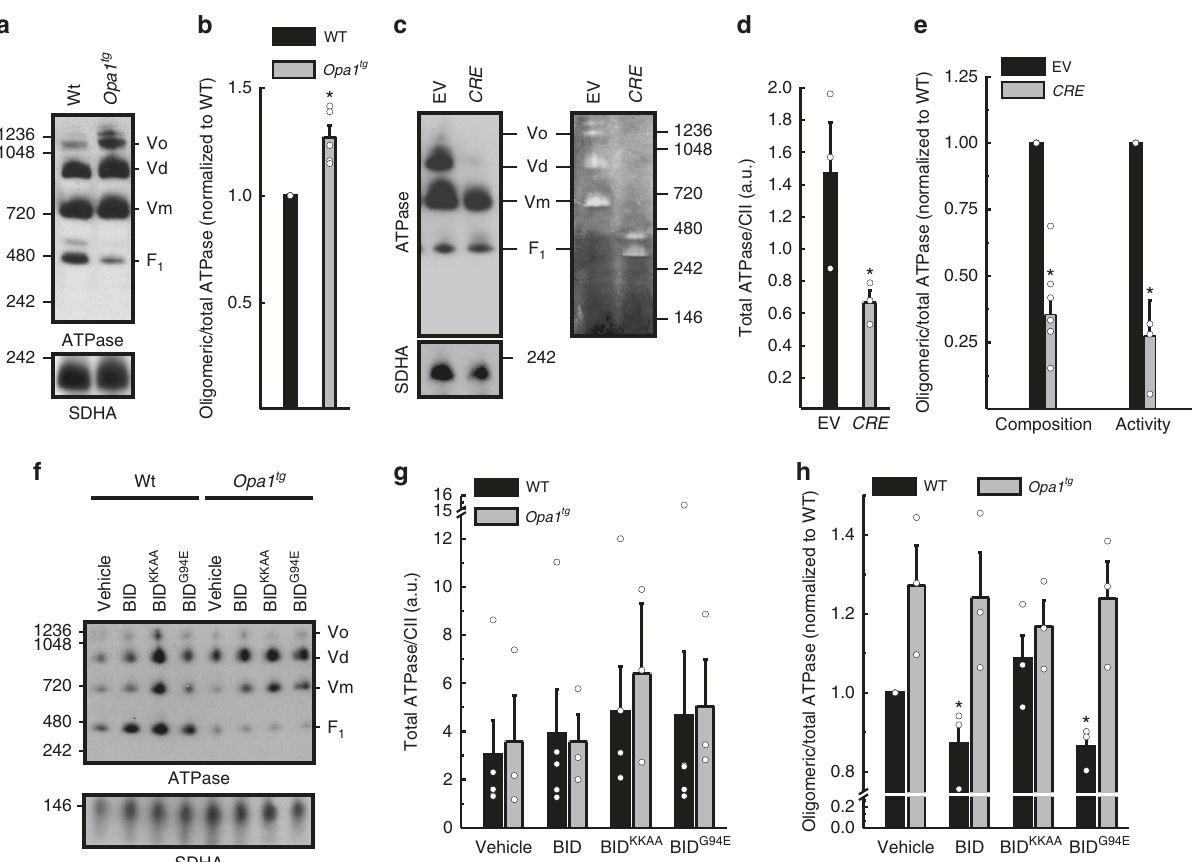
Fig. 3 OPA1 promotes stabilization of ATP synthase oligomers. a Equal amounts (40 µ g) of digitonin-solubilized mitochondrial extracts from MAFs of the indicated genotype were separated by BNGE and immunoblotted with anti-ATP synthase subunit α (ATPase) and Succinate Dehydrogenase (SDHA) antibodies. ATPase oligomers (Vo), dimers (Vd), monomers (Vm) and F 1 are indicated. b Densitometric analysis of experiments performed as in a . Data represent mean ± SEM of Vo + Vd (oligomeric)/total ATP synthase (Vo + Vd + Vm + F 1 ) from fi ve different experiments. * p < 0.05 in a two-way ANOVA vs. control. c Equal amounts (40 µ g) of digitonin-solubilized mitochondrial extracts from MAFs of the indicated genotype were separated by BNGE and immunoblotted with the indicated antibodies (left) or processed for ATPase activity (right). ATPase oligomers (Vo), dimers (Vd), monomers (Vm) and F 1 are indicated. d , e Quantitative densitometric analysis of total ATP synthase/CII (SDHA) ( d ) and of oligomeric/total ATP synthase conformations ( e ) in experiments as in c . Data show mean ± SEM of at least three independent experiments. * p < 0.05 in a two-way ANOVA versus EV. f Mitochondria from MAFs of the indicated genotypes were treated with recombinant BID as indicated for 30 min, lysed and equal amounts (40 µ g) of digitonin-solubilized extracts were separated by BNGE and immunoblotted with the indicated antibodies. g , h Quantitative densitometric analysis of total/CII (SDHA) ( g ) and of oligomeric/total ATP synthase conformations ( h ) in experiments as in f . Data are normalized to untreated cells and represent mean ± SEM of at least